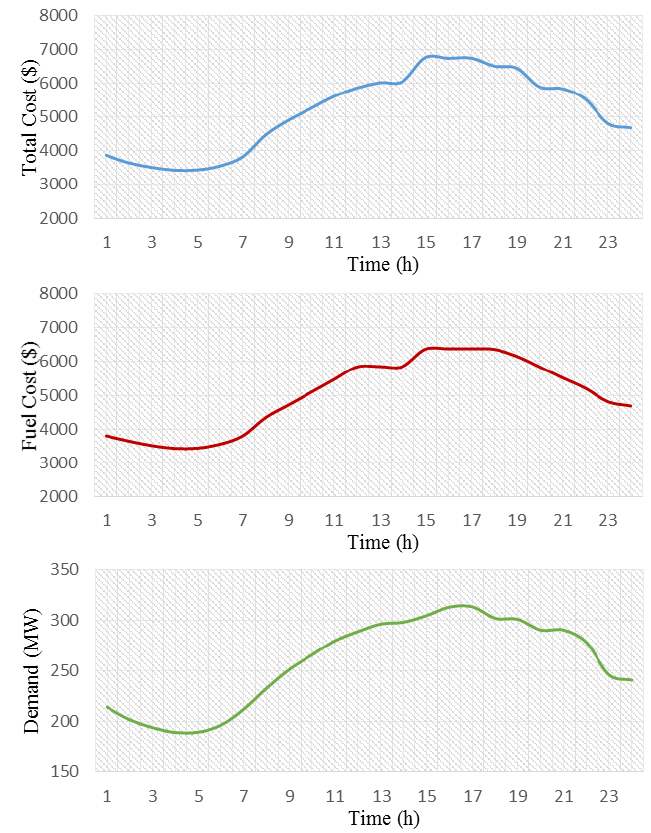
Figure 6. The curves of total operation cost, fuel cost of thermal units and the load demand in 24 h.